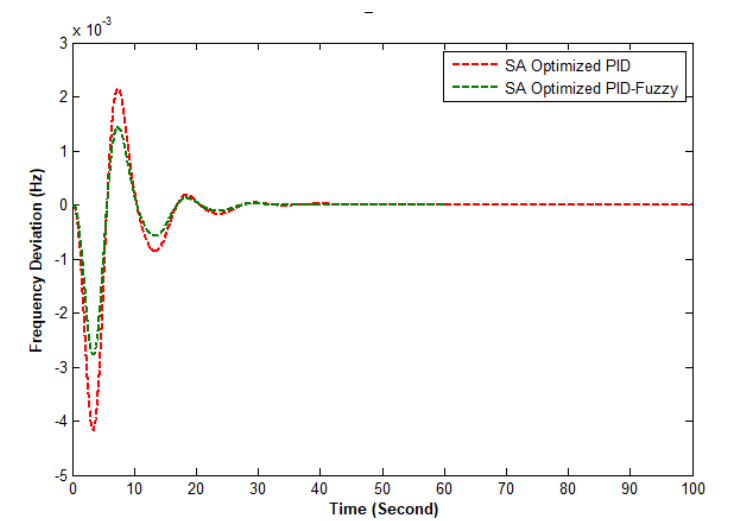
Figure 10. Frequency deviations in area 1 for the second case.